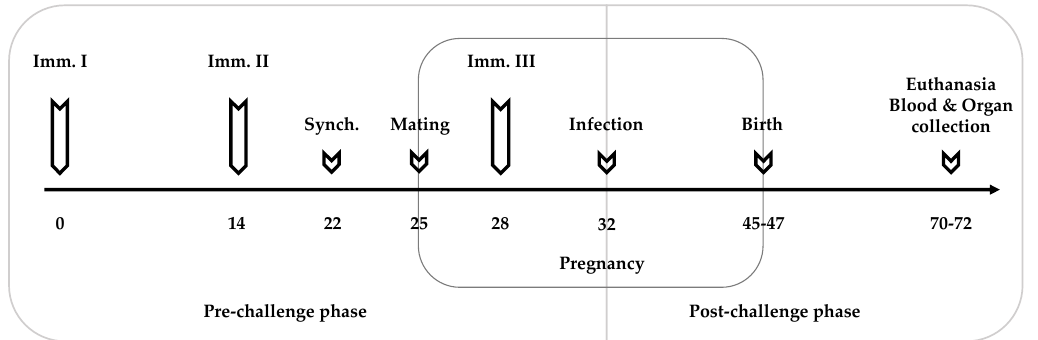
Figure 1. Experimental design. Mice were vaccinated three times (Imm. I–III) with the appropriate vaccine strain at two-week intervals (see Table 1). Three days before mating, the mice were oestrus- synchronized (Synch.) by the Whitten effect before two females were put together with one male. Seven days post-mating, corresponding to the first trimester of pregnancy, all mice, except the negative control, were infected with a sublethal dose of 1 × 10 5 NcSpain-7 tachyzoites. The mice were observed daily for clinical signs. Non-pregnant mice, dams and pups were euthanized between days 70–72, corresponding to 25 days p.p.